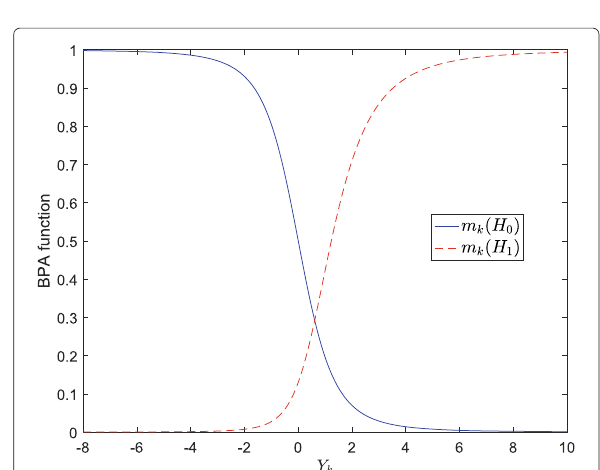
Fig. 2 Tendency of the BPA functions of Y k including m k ( H 0 ) under H 0 hypothesis and m k ( H 1 ) under H 1